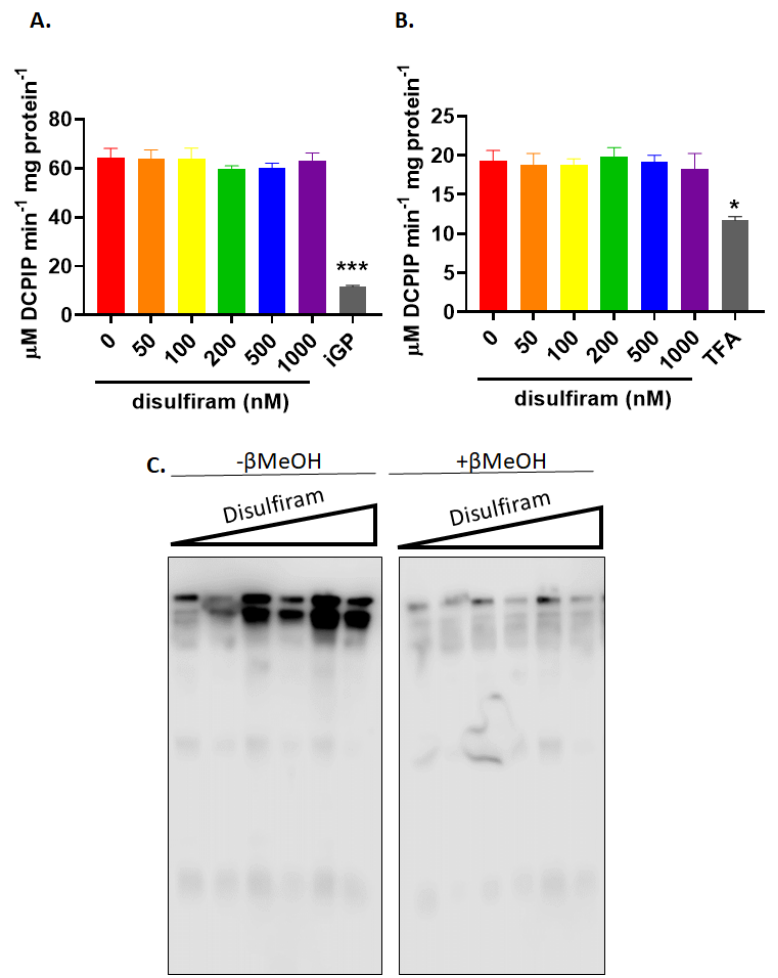
Figure 4. Disulfiram dose dependently increases the total number of protein glutathione mixed disulfides (PSSG) in mitochondria but does not alter the activities of ( A ) GPD and ( B ) PRODH. The activities of both enzymes were estimated using mitochondria treated with increasing doses of disulfiram and 1 mM GSH. The activity of GPD and PRODH was verified with iGP and TFA, respectively. N = 4, mean ± SEM, 1-way ANOVA with a post-hoc Fisher’s LSD test. * p ≤ 0.05, *** p ≤ 0.001. ( C ) Isolated mitochondria were subjected to immunoblot analysis for PSSG following treatment with disulfiram and 1 mM GSH. Samples were also electrophoresed under reducing conditions (with β -mercaptoethanol; + β MeOH) to confirm the specificity of the protein glutathione disulfide adduct (PSSG)